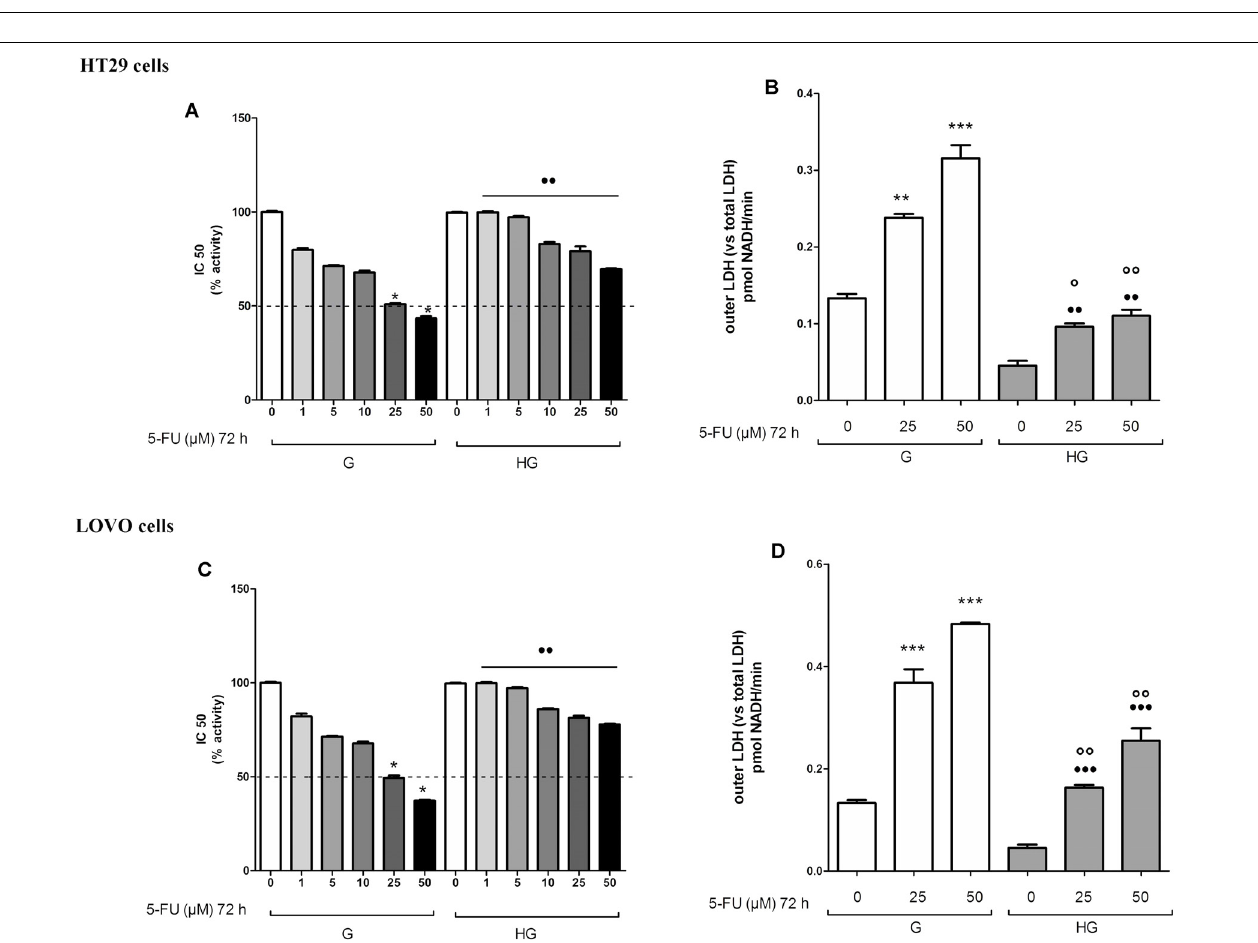
FIGURE 2 | Effect of normal glucose (G) and high glucose (HG) on cell proliferation and on LDH release from cells in the supernatant in absence or presence of 5-fluorouracil (5-FU) in human colon cancer (HT29 and LOVO) cells. Cells were cultured for ≥ 7 days in the presence of G and HG, then subjected to the following investigations. (A) Cells were left untreated or incubated for 72 h in the presence of different concentrations (1 µ M, 5 µ M, 10 µ M, 25 µ M, 50 µ M) of 5-FU (A,C) . Samples were then stained in quadruplicate with the neutral red solution ( n = 4) to assess cell viability. IC50 was calculated as the concentration of 5-FU that kills 50% (dotted line) of cells. ∗ p < 0.01 25 and 50 µ M 5-FU in HT29/LOVO cells cultured in G vs. 0 µ M 5-FU in HT29/LOVO cells cultured in G; •• p < 1, 5, 10, 25, 50 5-FU in HT29/LOVO cells cultured in HG, respectively, vs. 1, 5, 10, 25, 50 5-FU in HT29/LOVO cells cultured in G. (B) Cells were left untreated or incubated for 72 h with 25 µ M and 50 µ M of 5-FU (B,D) , then the LDH activity was measured. Measurements ( n = 8) were performed in duplicate. ∗∗∗ p < 0.0001 25 and 50 µ M 5-FU in HT29/LOVO cells cultured in G vs. 0 µ M 5-FU in HT29/LOVO cells cultured in G; ∗∗ p < 0.001 25 µ M 5-FU in HT29 cells cultured in G vs. 0 µ M 5-FU in HT29 cells